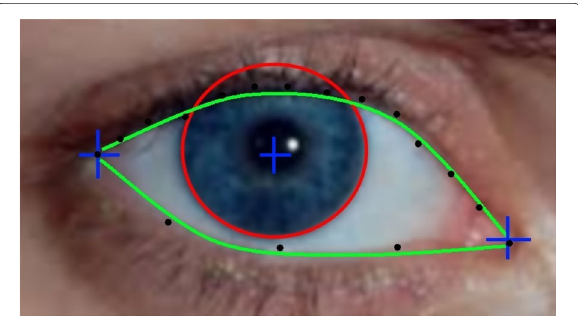
Fig. 6 Example of designation searched points and edges, under the